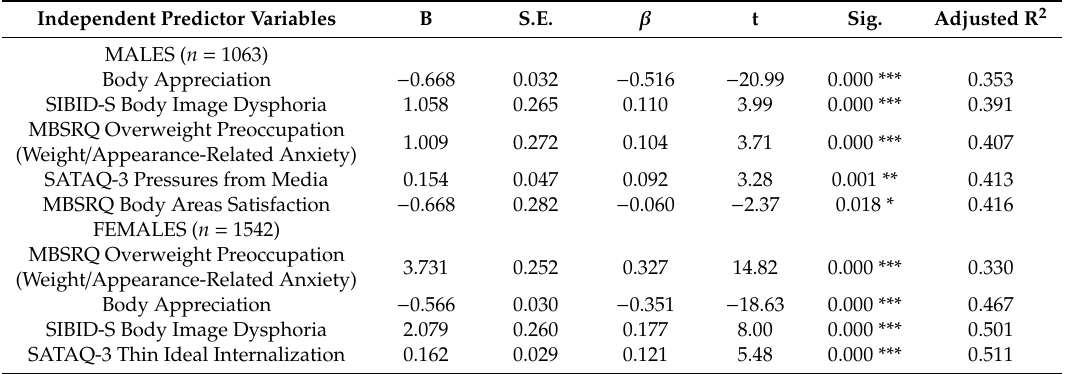
Table 1. Summary of multiple regression of males and females predicting disordered